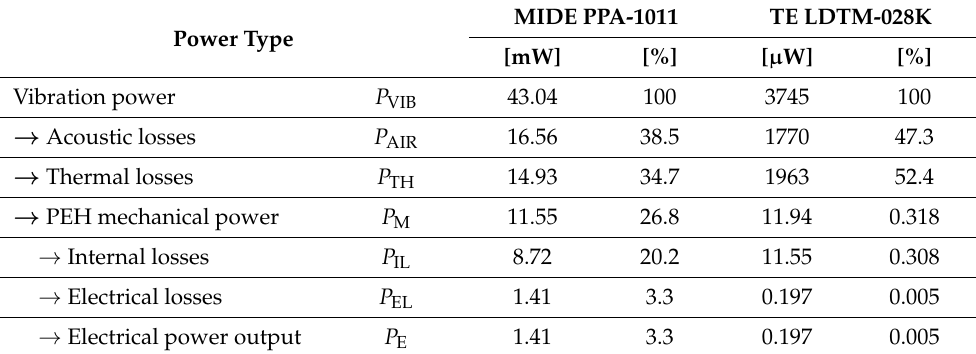
Table 1. Comparing the individual power components in the tested PEHs at 1 g